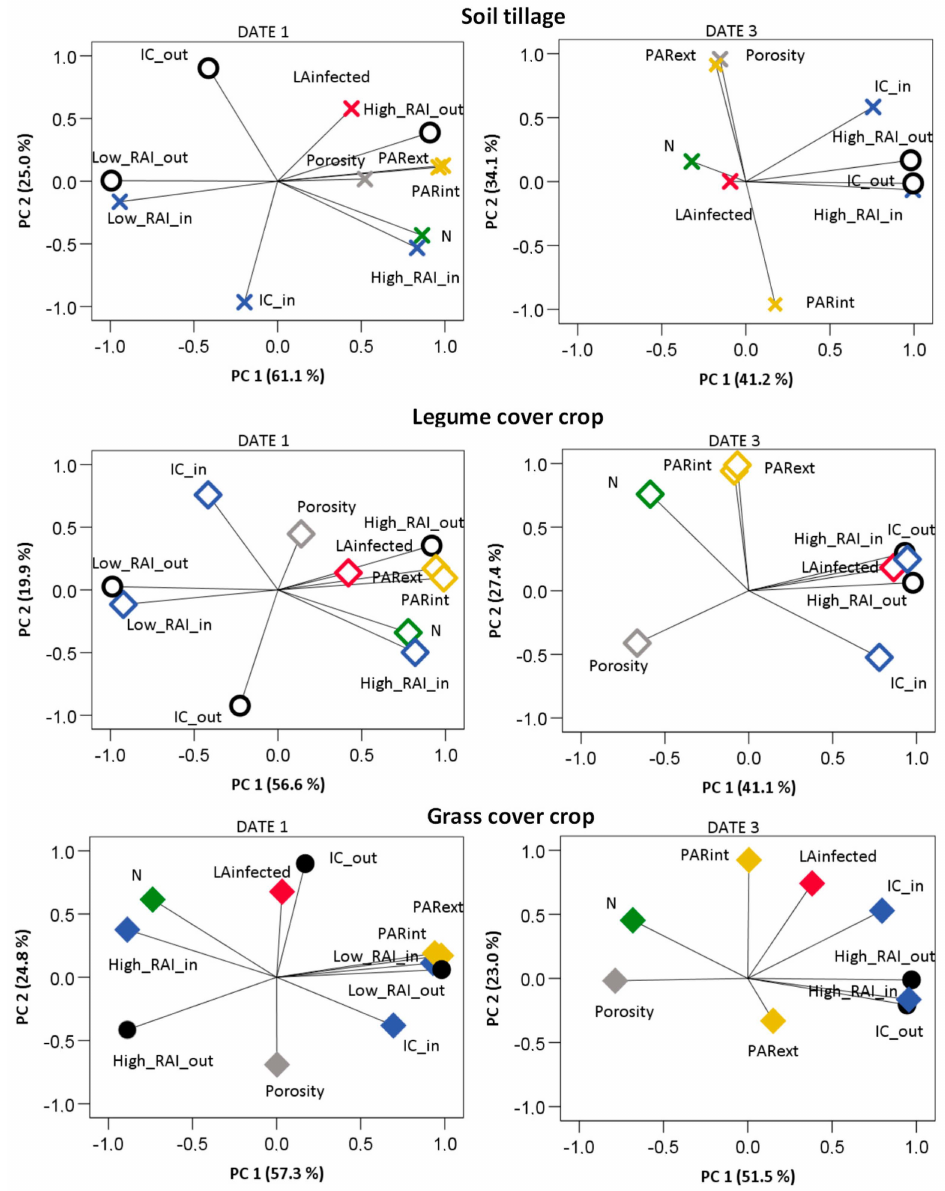
Figure 13. Multifactor analysis score plots of the infected LA per shoot, leaf N, canopy porosity, PAR levels in the external and internal layers, and IC and RAI classes (low and high), inside (in) and outside (out) the canopy, in each soil management treatment (ST—dark cross, LEG—empty rhombus; GRA—full rhombus) during the grapevine powdery mildew observation dates 1 and